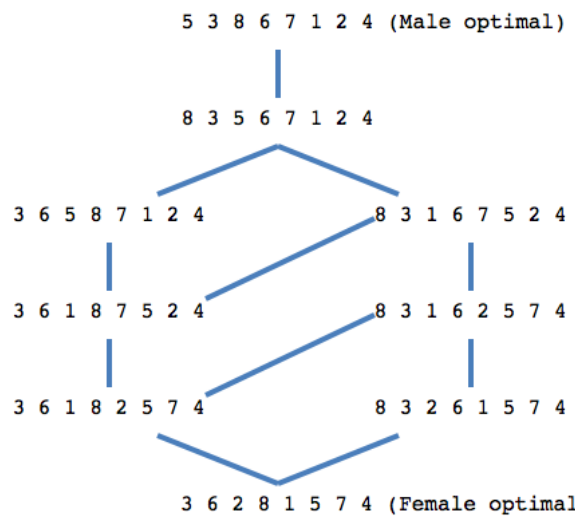
Figure 1. The Hasse diagram of the set of all stable marriages for the SM in Table